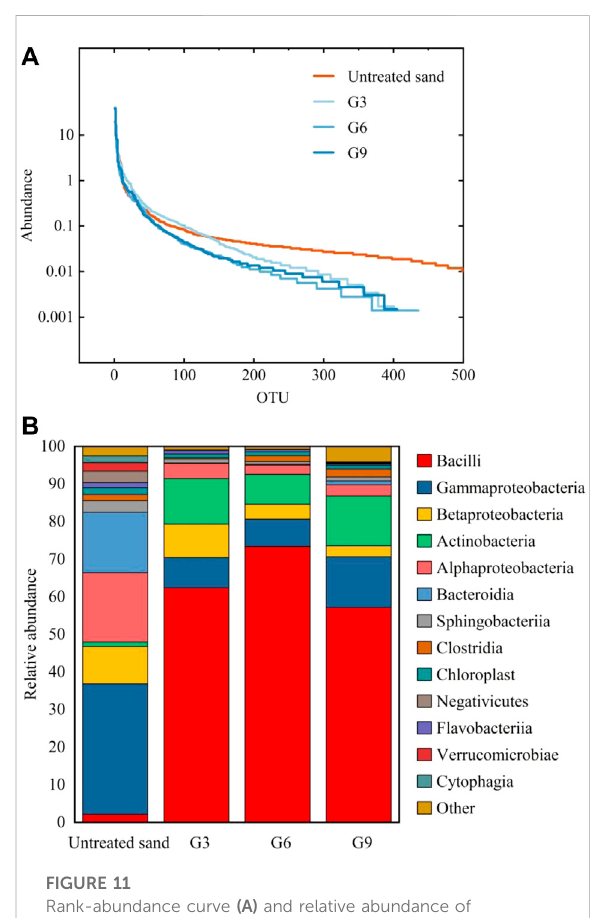
FIGURE 11 Rank-abundance curve (A) and relative abundance of microorganisms (B) in different